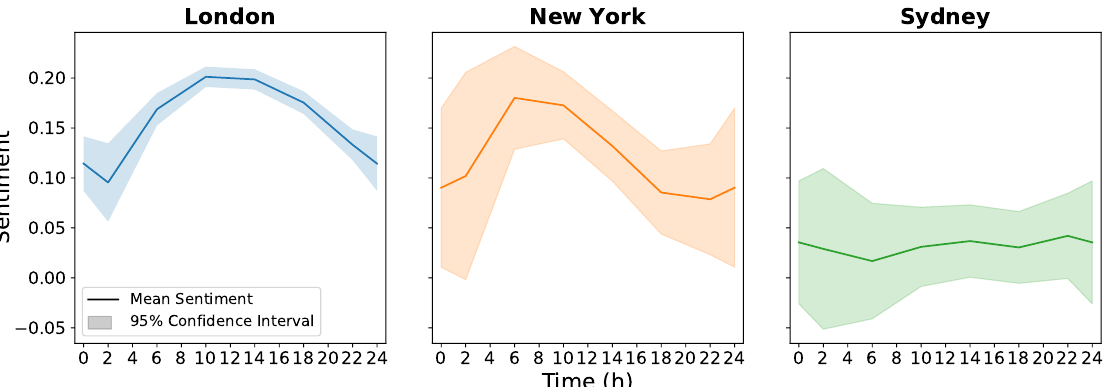
Figure 6. Average sentiment over the heatwave days for each city with a 95% confidence